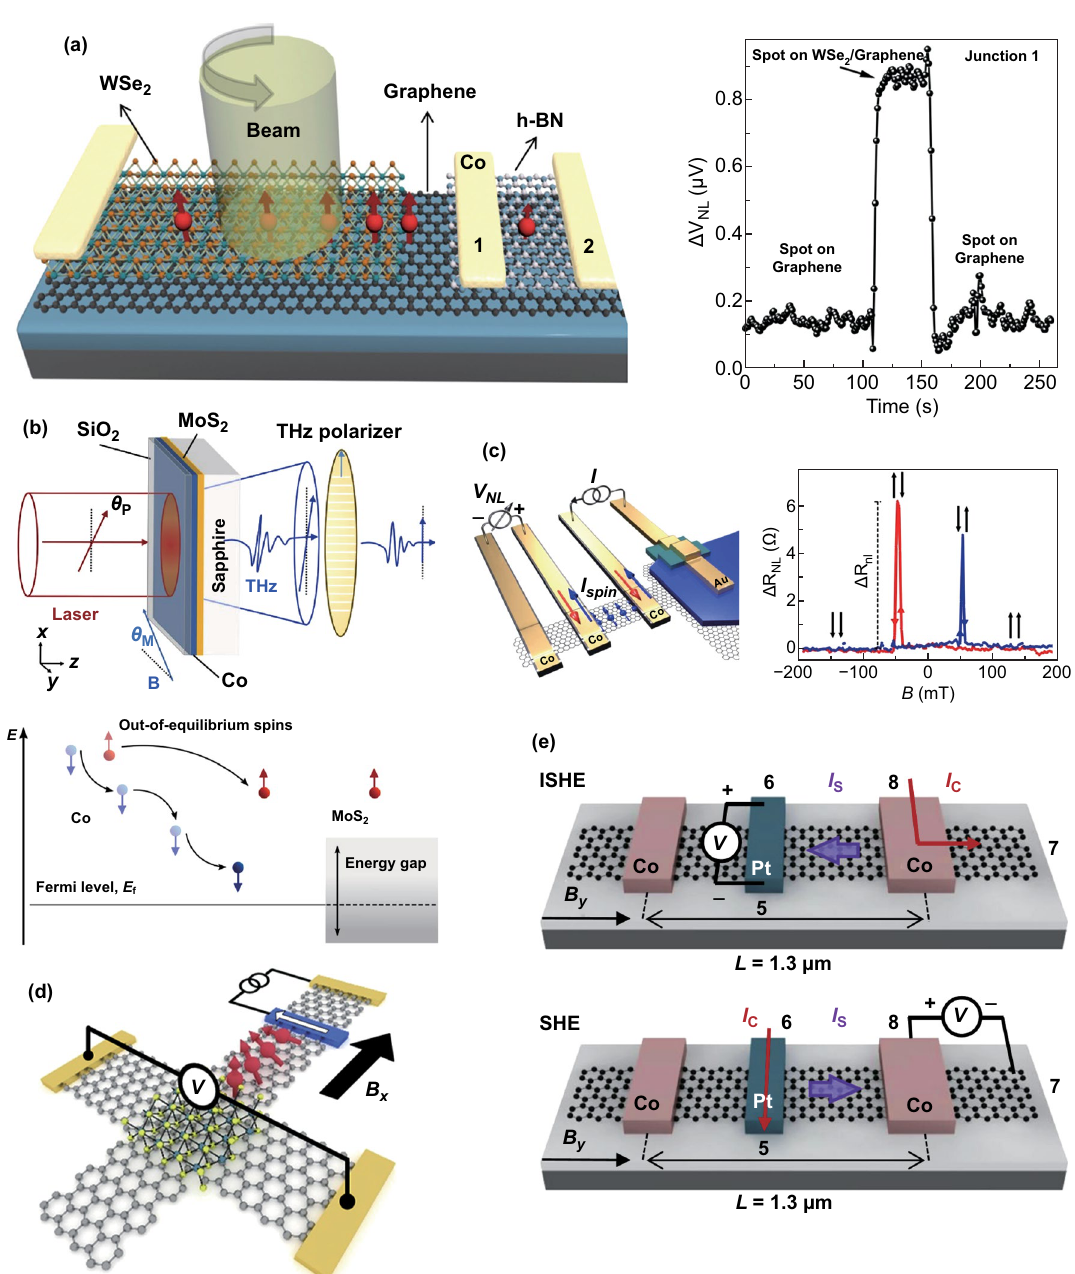
Fig. 4 a Schematic of the optical injection structure with WSe 2 . Utilizing circularly polarized light, the spin‑polarized electrons will generate in WSe 2 , and then diffuse into graphene and cause non‑local spin signals, as shown on the right. When there is no light, the signal is in its initial state. And once there is light, the signal rises rapidly [104]. b Schematic of Co/MoS 2 heterostructure and experimental configuration. The figure below describes the principle of spin injection [105]. c Schematic of Bi 2 Te 2 Se/graphene heterostructure spin injection and the non‑local spin sig‑ nals [85]. d Schematic of spin Hall effect in graphene with MoS 2 at room temperature [119]. e Spin‑to‑charge conversion in a trilayer graphene/ Pt lateral heterostructure. Sketch of the inverse spin Hall effect (top) and spin Hall effect (bottom) measurement configurations [120]. Figures reproduced with permission from Refs. [85, 104, 105, 119,